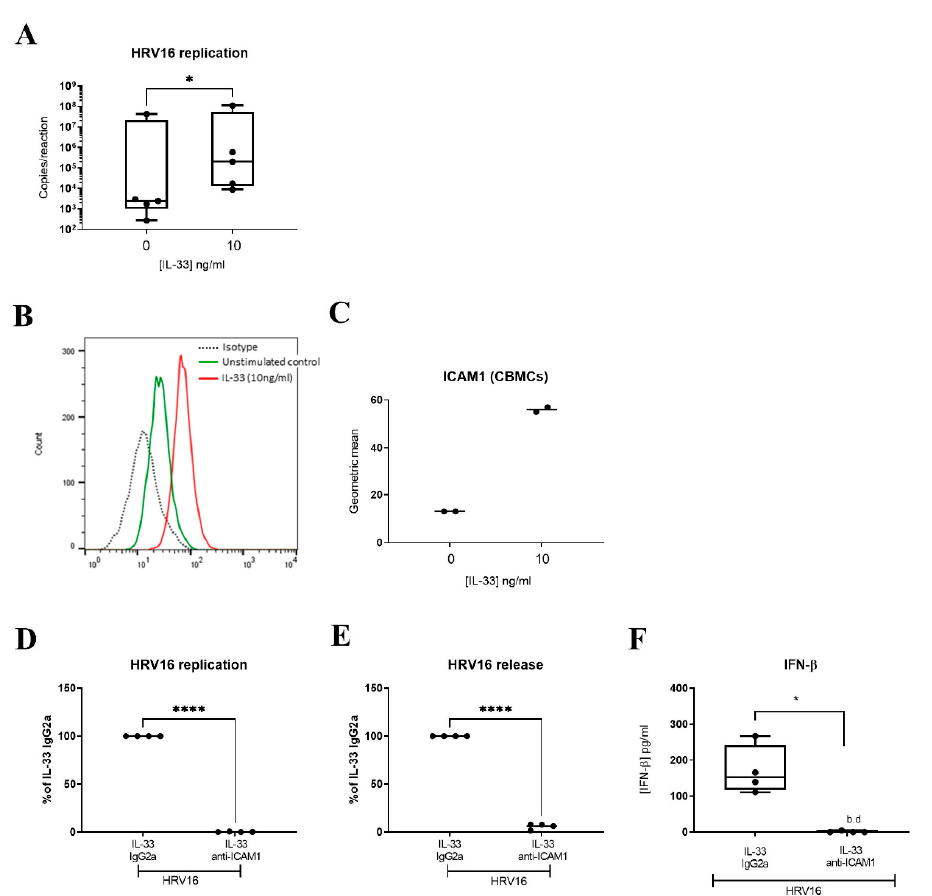
Figure 6. Role of ICAM1 in mediating IL-33-dependent enhancement of HRV16 replication in CBMCs. Viral RNA in CBMCs pretreated with or without IL-33 (10 ng/mL) for 24 h prior to HRV16 infection (MOI 7.5) for a further 24 h, n = 5 ( A ). A representative flow cytometric trace ( B ) and averaged geometric mean ( C ) for ICAM1 cell surface expression in MCs treated with IL-33 (10 ng/mL) for 24 h, n = 2. HRV16 replication ( D ), virion release ( E ) and IFN- β release ( F ) following IL-33 (10 ng/mL) stimulation for 24 h prior to HRV16 infection (MOI 7.5) in the presence or absence of anti-ICAM1 antibody or IgG2a isotype for a further 24 h, n = 4. * p ≤ 0.05 for no cytokine versus IL-33 and * p ≤ 0.05, **** p ≤ 0.0001 for IL-33 IgG2a+HRV16 versus IL-33 anti-ICAM1+HRV16.